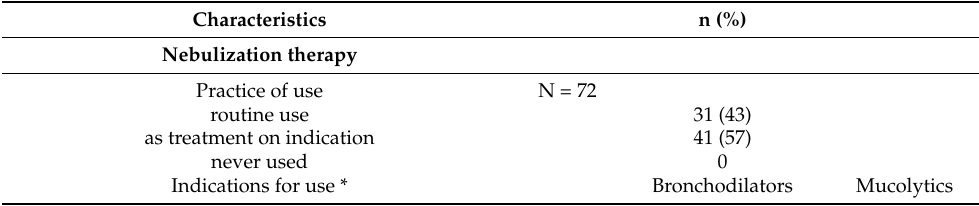
Table 2. Airway care